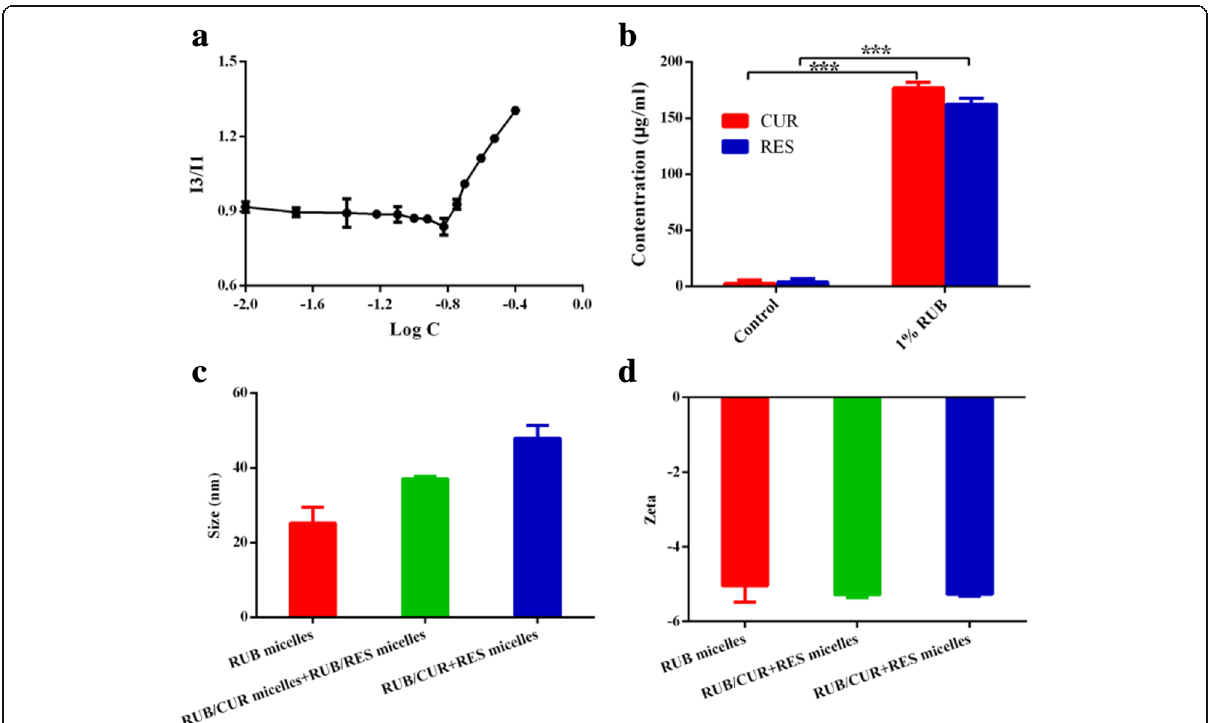
Fig. 3 Characterization of RUB-based micelles. a Determination of critical micelle concentrations (CMC) of RUB micelles using pyrene as fluorescent probe. The CMC was calculated as 0.18 mM. b RUB micelles were adopted to load CUR and RES for significantly enhancing their solubility. *** P <0.001 (two-tailed Student ’ s t test). c , d The size and zeta potential of RUB-based micelles were measured by dynamic light scattering (DLS). Error bars indicated s.d. ( n